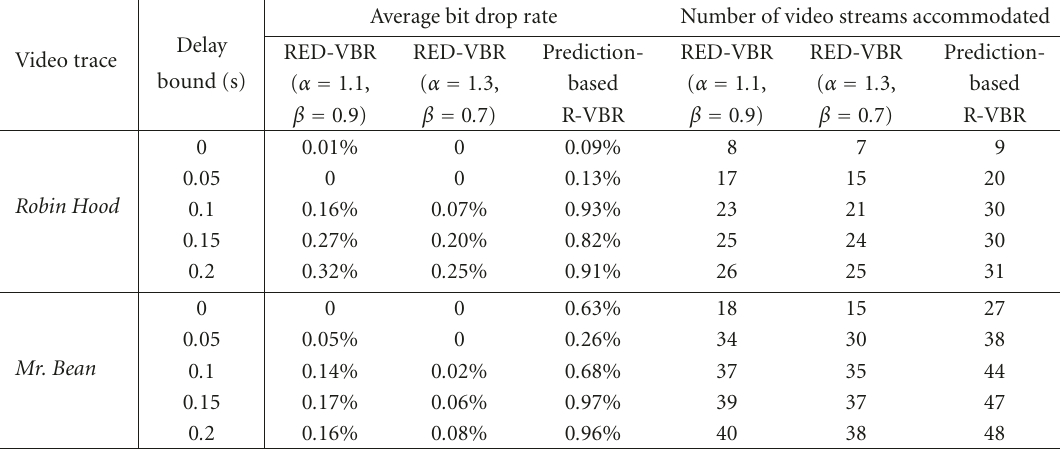
Table 1: Comparison of bit drop rate and the number of video streams accommodated.